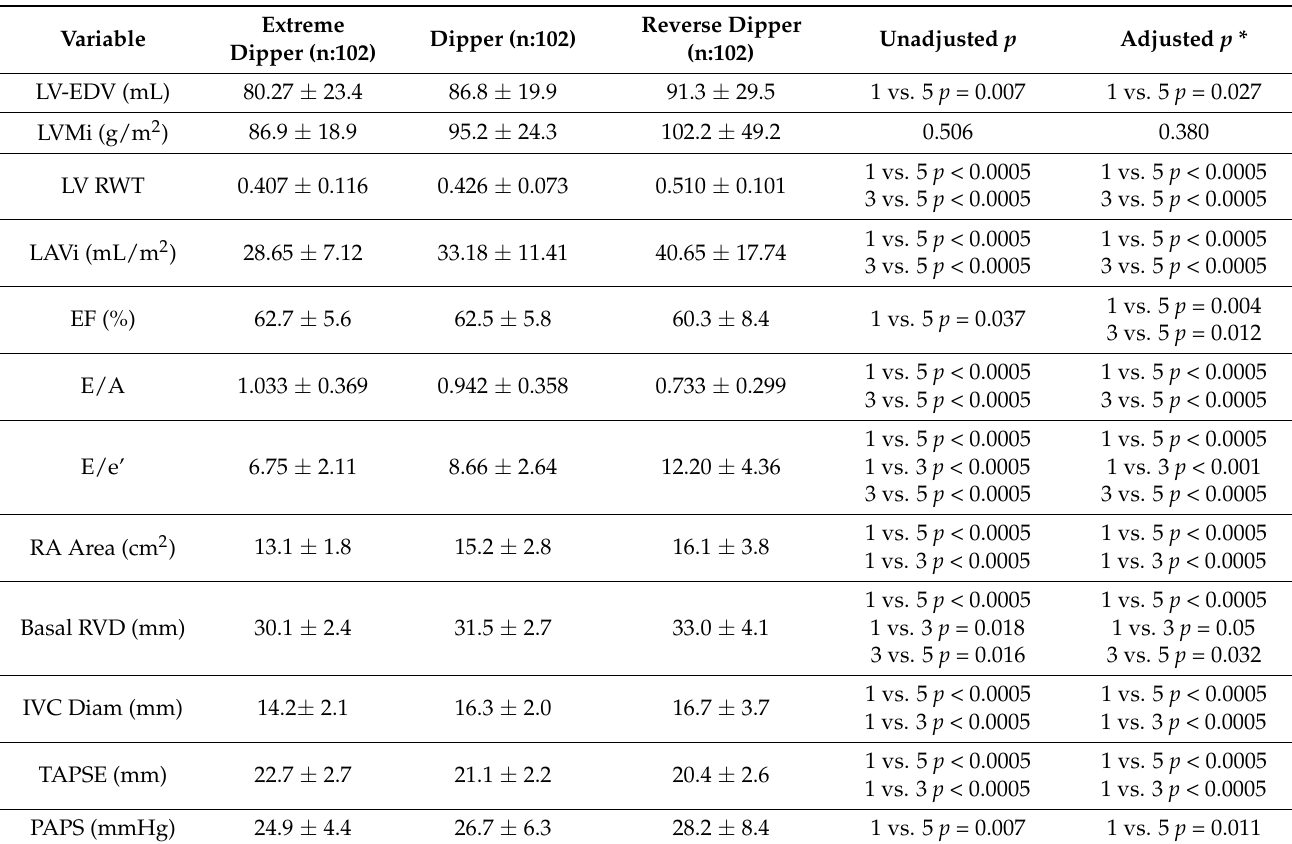
Table 3. Echocardiographic data of hypertensive subjects according to quintiles of percentage fall in mean nocturnal systolic blood pressure in comparison to mean diurnal systolic blood pressure.